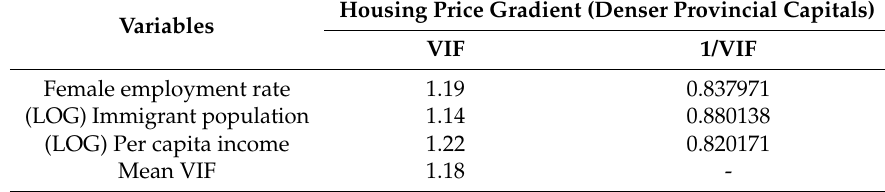
Table 8. Estimation of the variance inflation